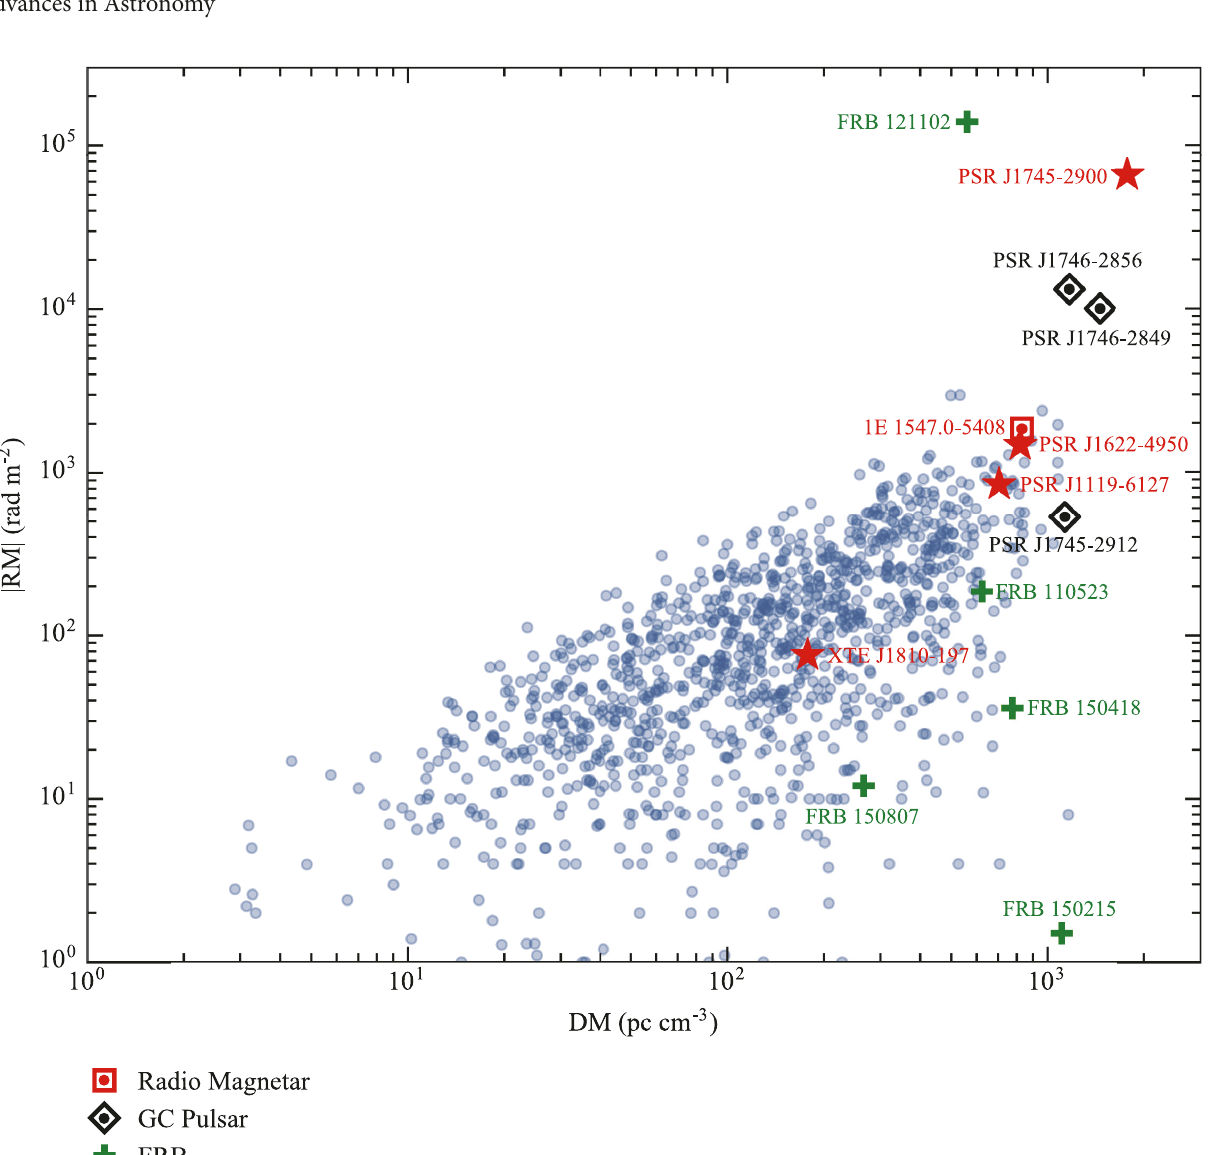
Figure 2: Magnitude of the Faraday rotation measure (RM) versus dispersion measure (DM) for all known pulsars (blue circles) in the AustraliaTelescopeNationalFacility (ATNF)pulsar catalog(see https://www.atnf.csiro.au/people/pulsar/psrcat) [36]. Welabel the four radio magnetarsconsidered in this paper, PSR J1745–2900, PSR J1119–6127, PSR J1622–4950, and XTE J1810–197, using red stars. The one other radio magnetar, 1E 1547.0–5408, is indicated by a red square. We also show the Galactic Center (GC) pulsars using black diamonds and the four fast radio bursts (FRBs) with RM measurements in the FRB catalog (see http://frbcat.org) [38] using green